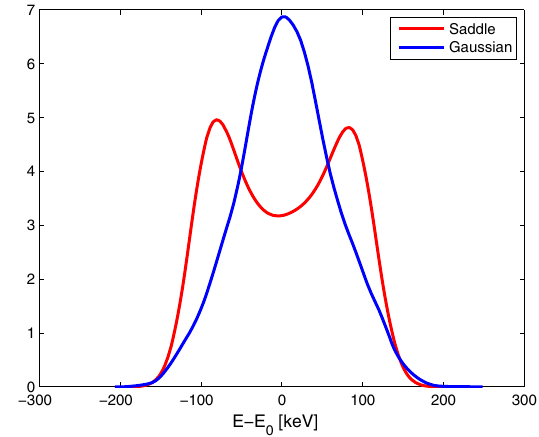
FIG. 5. The PEHG bunching factor vs the harmonic number. The filled curves are calculated by Eqs. (4) and (9), the colorized dots represent the simulation results.